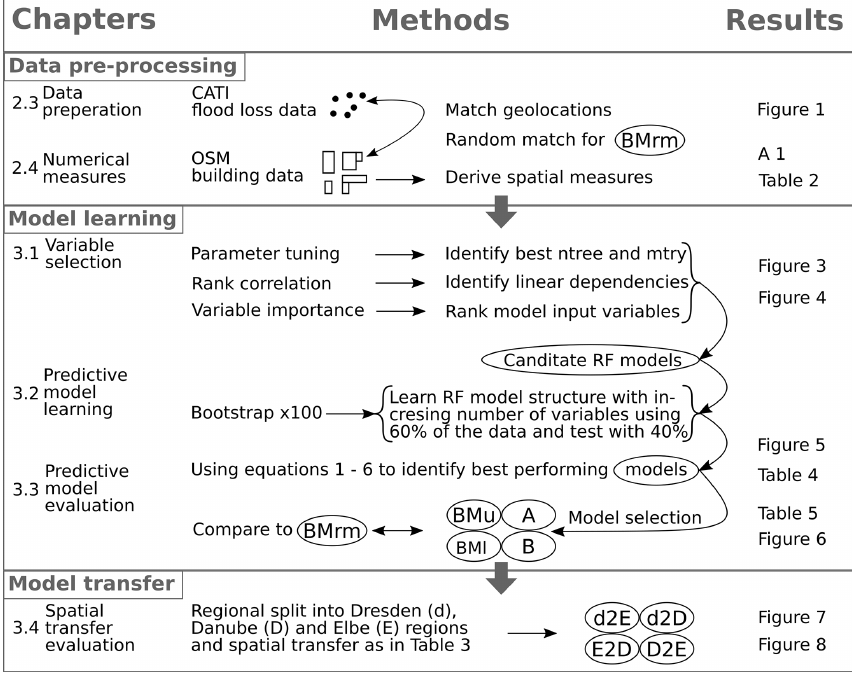
Figure 2. Data pre-processing, model learning and model transfer workflow with BMu (upper-benchmark model); BMl (lower-benchmark model); BMrm (benchmark model with random match of interview locations with OSM building data); A (random forest model using eight predictors); B (random forest model using eight predictors); and model transfers d2E (learning with Dresden and predictions for Elbe), d2D (learning with Dresden and predictions for Danube), E2D (learning with Elbe and predictions for Danube) and D2E (learning with Danube and predictions for